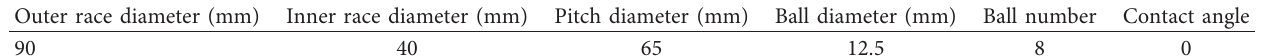
Figure 11: Bearing-rotor testbed: (a) electromotor; (b) signal conditioner; (c) bearing pedestal; (d) piezoelectric accelerometer. Table 1: Rolling bearing parameters.